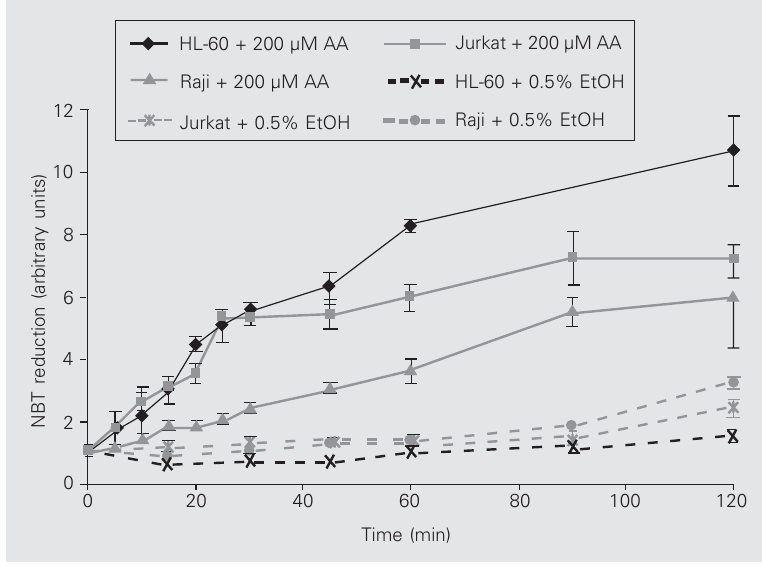
Figure 3. Kinetics of baseline nitroblue tetrazolium (NBT) reduction and of NBT reduction stimulated with arachidonic acid (AA) in leukemia cell lines. The experimental conditions are the same as those described in the legend to Figure 1. Cells were treated for different periods of time with 0.5% ethanol (EtOH) or 200 µM AA. Results are reported as mean ± SD relative absorbance in relation to the value at time zero. The number of samples was